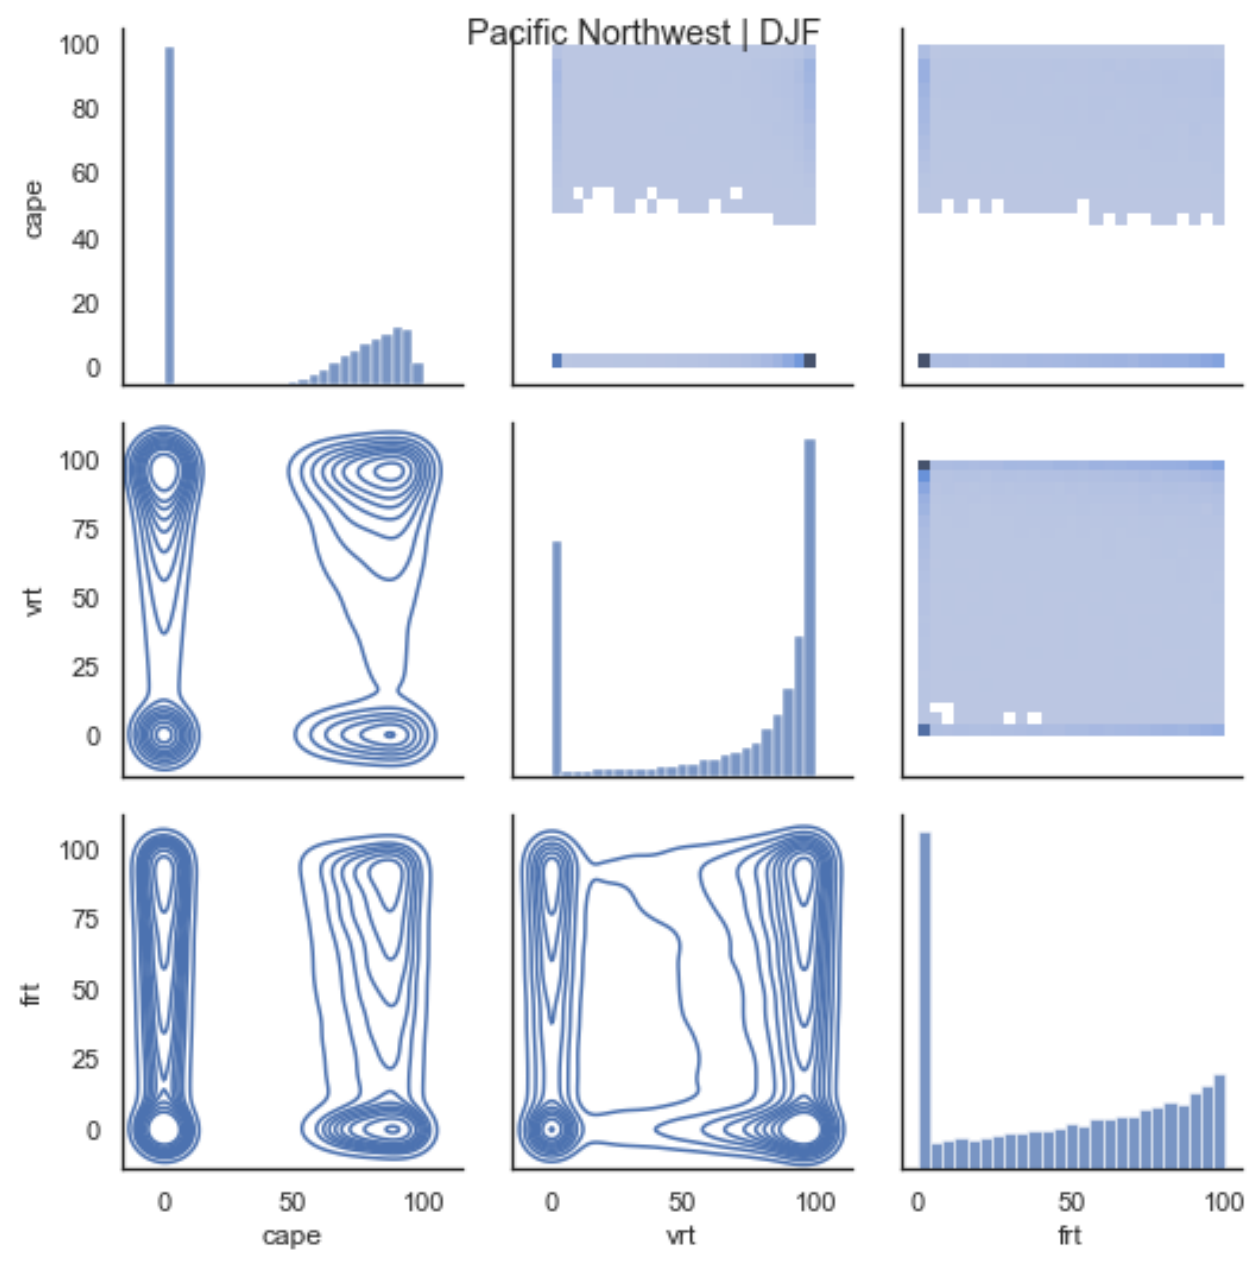
Figure 6. The plots along the diagonal are the univariate distribution of each of the three processes (Convection, Vorticity, and Frontal). The x -axis is the rank of the process and the y -axis is a density function over all events in the named region and season. The lower triangular panels show a kernel density plot of the two processes indicated on the corresponding x and y axis labels. The upper triangular panels show the same data as a bivariate